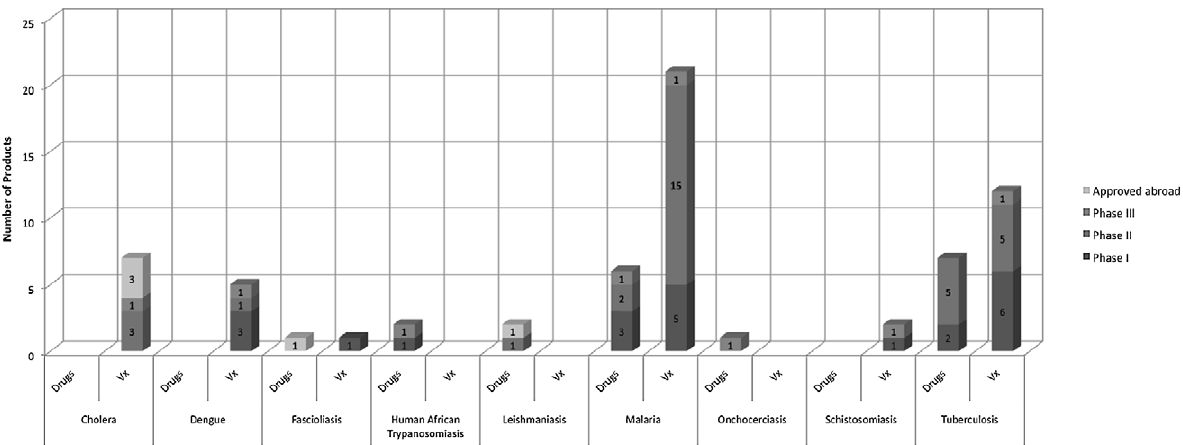
Figure 2. Number of PRV-eligible drugs and vaccines in the pipeline by phase of clinical development. Drugs and vaccines from the pre-clinical phase of development, through phases I, II, and III were evaluated for PRV eligibility (Figure 1). A total of 17 drugs in clinical development could earn a PRV, if approved by the FDA; two more are already approved abroad and would be eligible to earn a voucher if submitted to the FDA (six in phase I; eight in phase II; three in phase III). Forty-five vaccines are currently undergoing clinical development (16 in phase I; 24 in phase II; five in phase III); three additional vaccines are already approved abroad and would be eligible to earn a PRV if submitted to the FDA. The analysis excluded programs that are ‘‘on